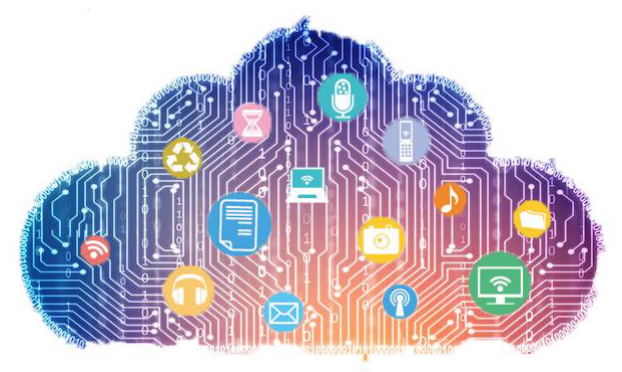
Figure 3. Big Data and Cloud Computing integration.